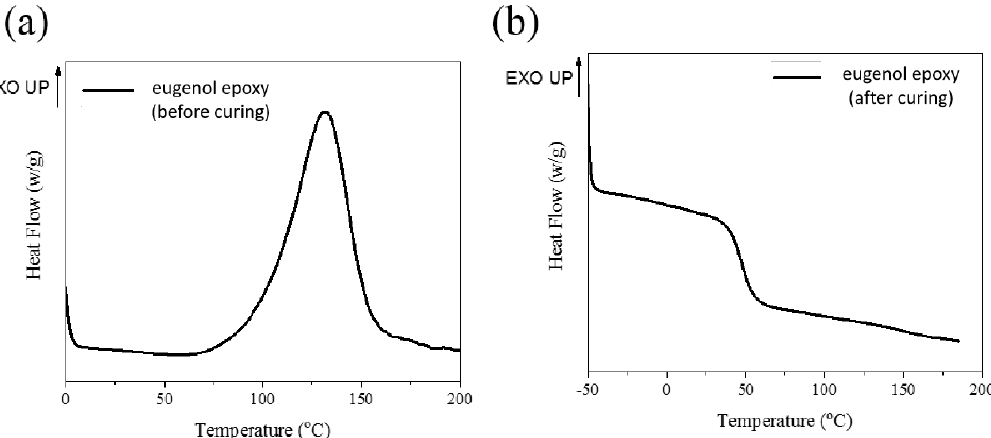
Figure 2. Differential scanning calorimetry (DSC) thermograms of EE before curing ( a ) and after curing ( b ).